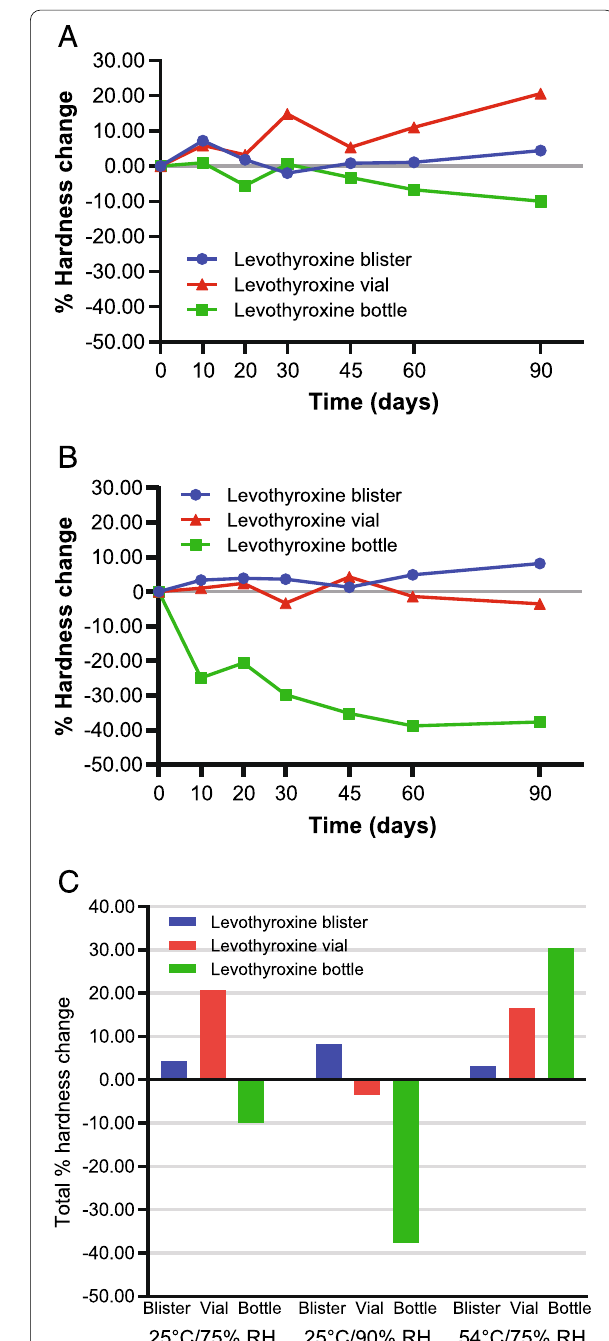
Fig. 2 Hardness change of levothyroxine tablets. A Percent hardness change over time: 25 °C/75% RH. B Percent hardness change over time: 25 °C/90% RH. C Total percent hardness change under 90-day patient use or 2-day shipping conditions. Abbreviation: RH,